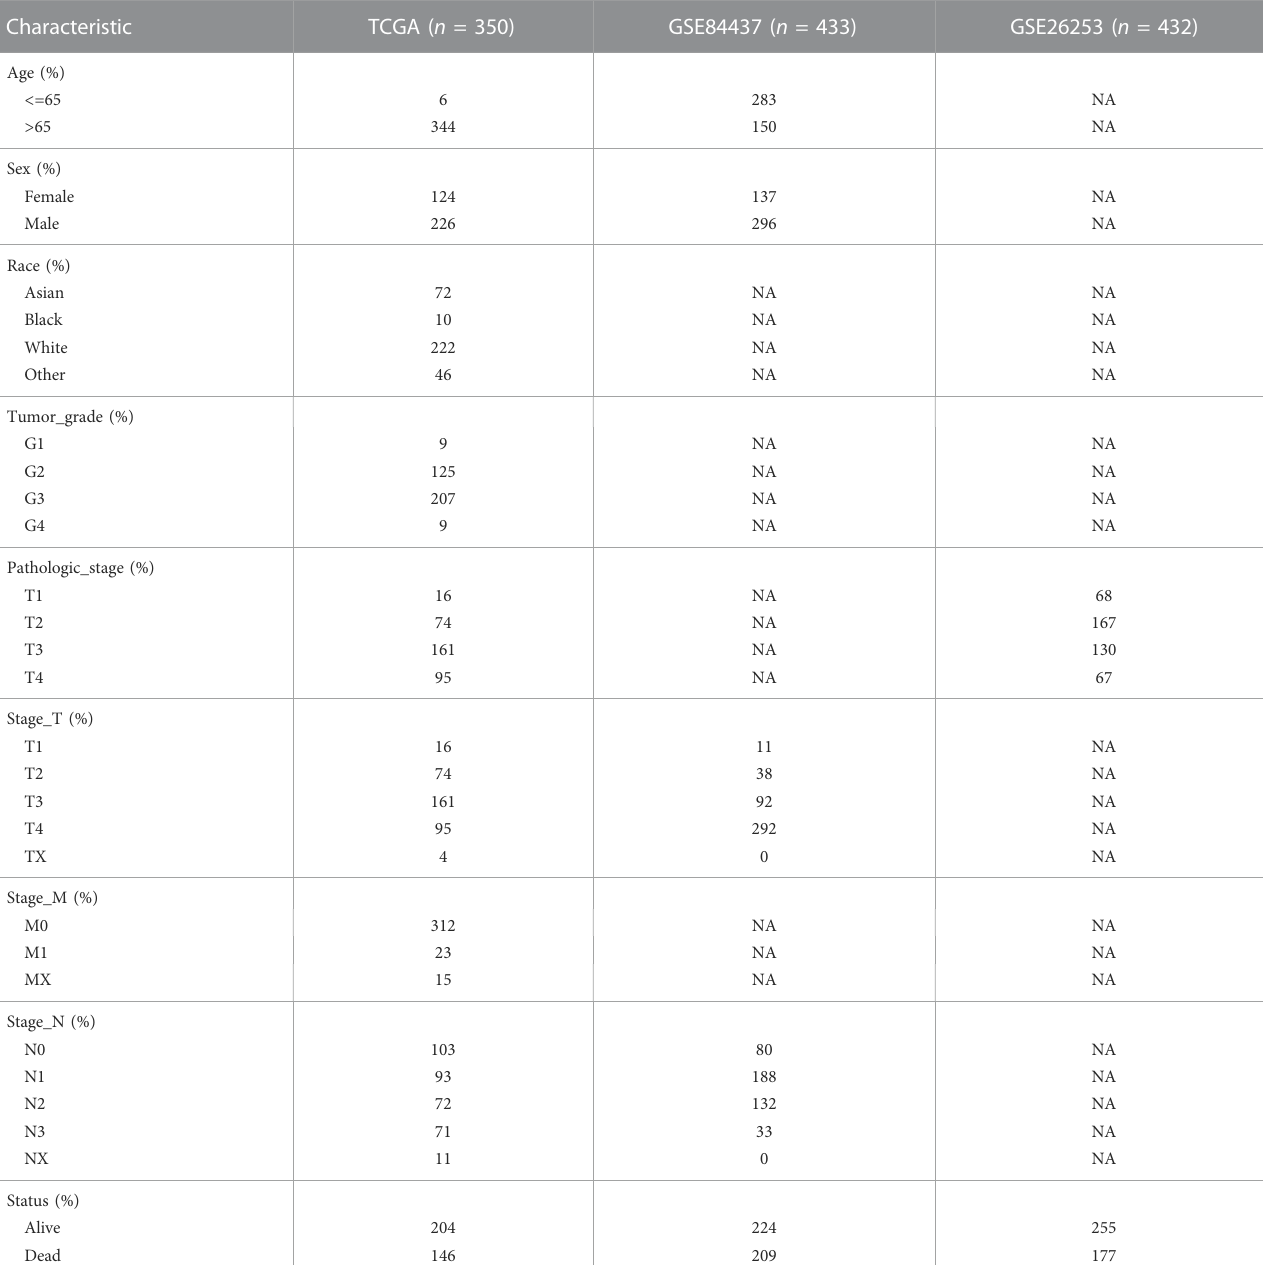
TABLE 1 Clinical baseline information of patients from TCGA and GEO.